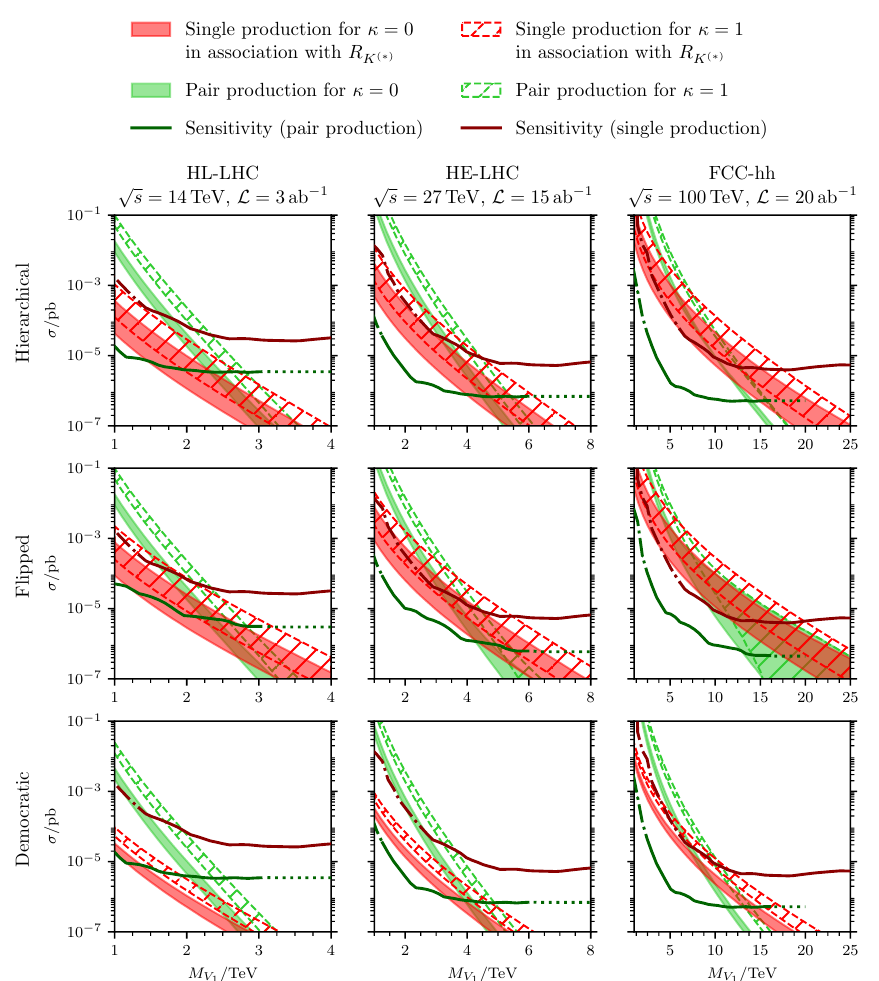
Figure 4 . V 1 -leptoquark production in pp -collisions in the flavor scenarios introduced in section 2.2 (rows) for different future collider experiments (columns). Red bands: single production cross (–) ± 2 / 3 section for σ ( pp → V ± 2 / 3 ( → µ ± ( → µ ± j ) µ ∓ ) , derived from the R K,K ∗ -band b ) µ ∓ ) + σ ( pp → V 1 1 in eq. (2.10) for hierarchical and flipped scenarios, and eq. (2.13) for the democratic scenario. Light green: pair production with final states ( bµ, bµ ) for the hierarchical and democratic scenarios and ( qµ, qµ ) for the flipped scenario. The error bands for pair production are evaluated by combining the pdf-, and scale uncertainties. Results for κ = 1 are shown in a dashed/hatched form together with the solid curves for κ = 0 . The solid dark red and the dark green curves depict the projected experimental sensitivity for single and pair production, respectively. As the starting curves for these extrapolations, we used the results of the measurements by the CMS [25] and ATLAS [22] collaborations, for the single- and pair production, respectively, see section 3.5 for details. The dot-dashed segments of the extrapolated curves for the low masses required additional smooth variation of the luminosities between the initial and the target values, following the prescription in ref. [79]. The dotted segments for the large masses represent the smooth continuation above the final extrapolated points towards the higher masses with the constant values of the cross-section limit. Neither of these segments play a role in determining the mass reaches shown in table